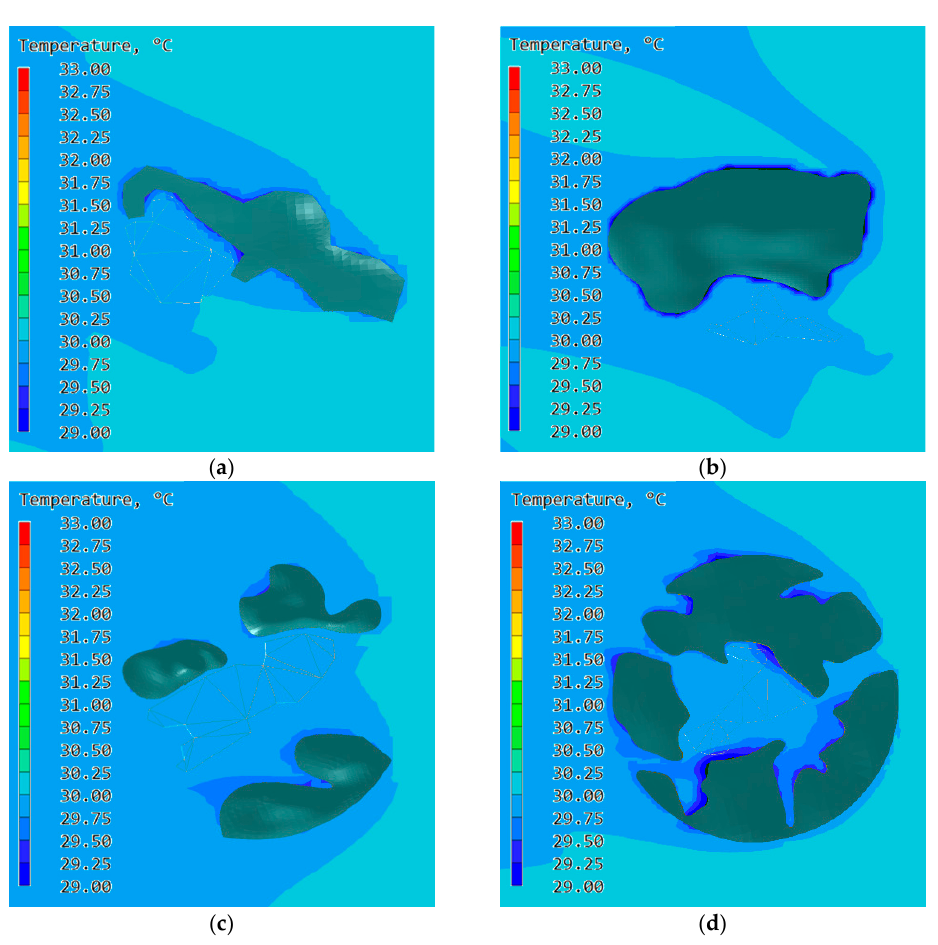
Figure 10. ( a ) Summer thermal environment simulation in Xiasong village; ( b ) Summer thermal environment simulation in Rongfang village; ( c ) Summer thermal environment simulation in Zhuqiao village; ( d ) Summer thermal environment simulation in Xuyuan village.